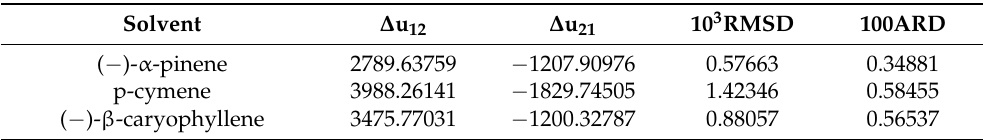
Table 7. Regression results and model parameters of the UNIQUAC model of dehydroabietic acid in solvents.